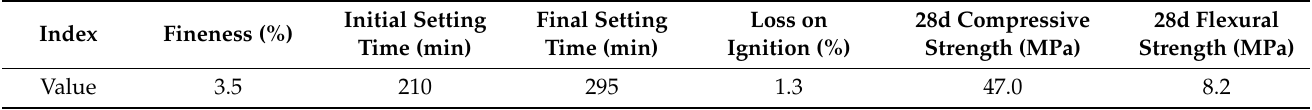
Table 3. Physical and mechanical indexes of cement.